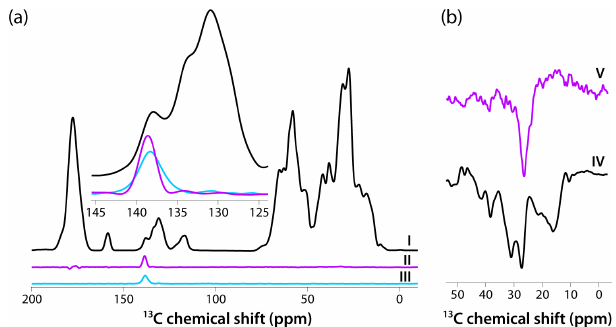
Figure 4. (a) CPMAS-based spectra acquired with pulse sequences shown in Fig. 1a–c are colored in black, magenta, and blue, respec- tively. The inset is an expansion around the aromatic region where the DANTE excitation pulse was applied (139ppm). The homoge- neous line width is 2.4ppm (362Hz). (b) Direct polarization spec- tra acquired using pulse sequences shown in Fig. 1d, e are colored in black and magenta, respectively. The homogeneous line width is 3.7ppm (559Hz). The spectra were acquired at 14.1T (150.96MHz 13 C Larmor frequency) at a MAS frequency of 24kHz and 120K sample